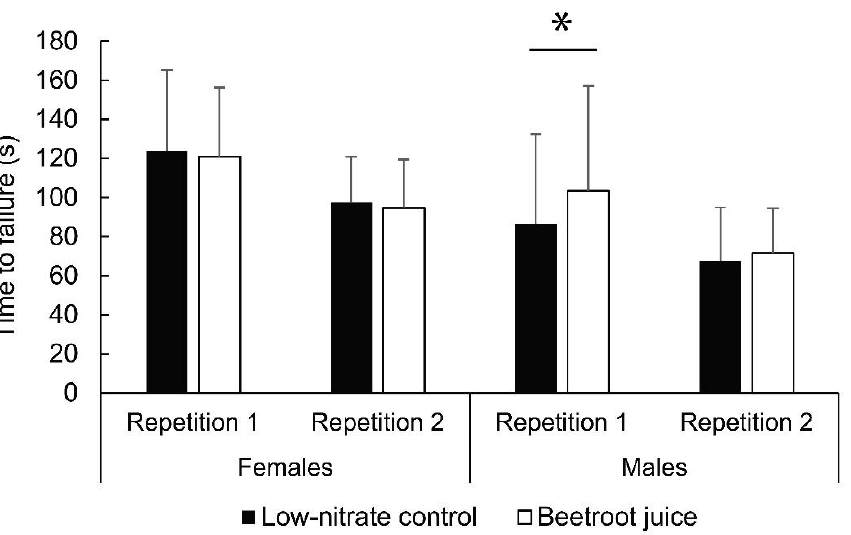
Figure 4. Results regarding muscle endurance (time to failure). * Statistically significant difference at p < 0.05.